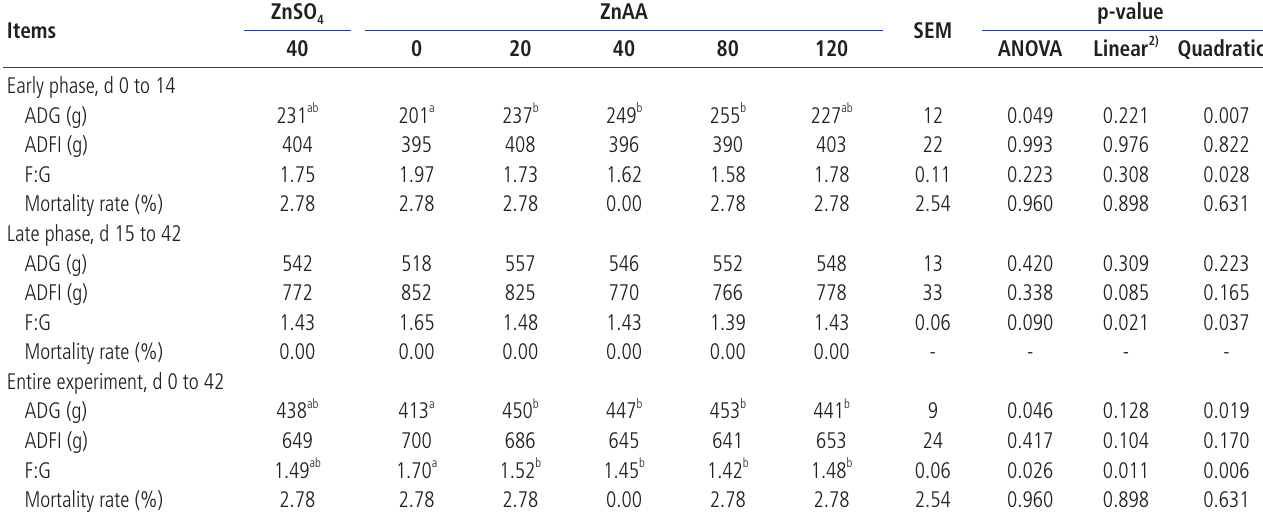
Table 3. Effects of zinc sulfate and zinc amino acid complex (ZnAA) on growth performance in weanling pigs 1) (Zn, mg/kg) Items Early phase, d 0 to